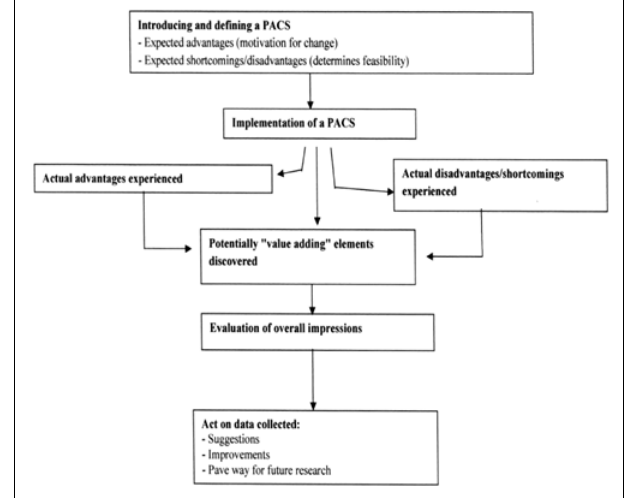
Fig. 1. A schematic representation of the events following implementation of a